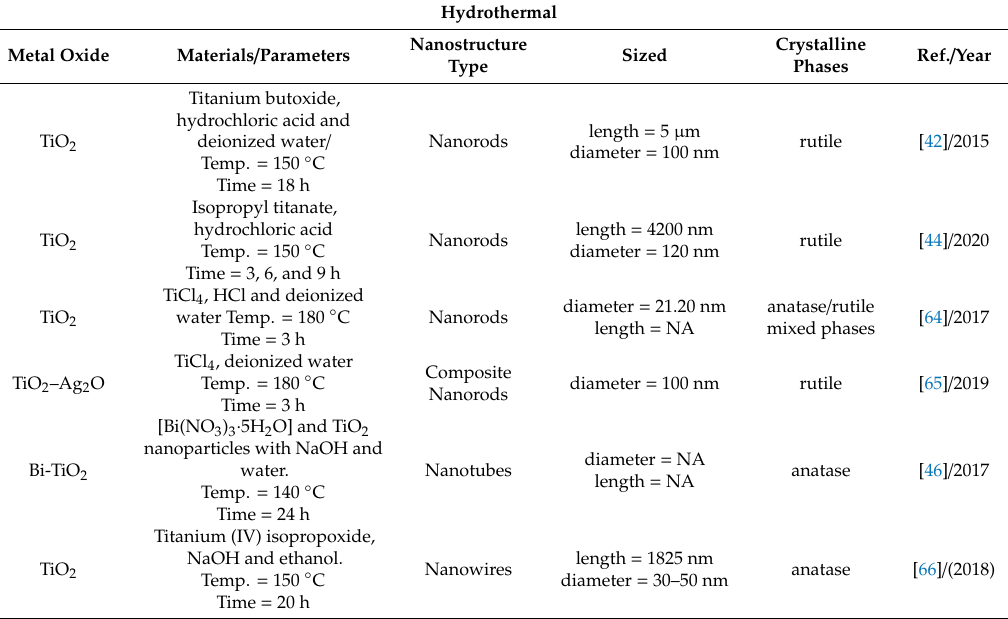
Table 2. Summarization of di ff erent materials, parameters, crystal phase involved in the growth process of TiO 2 nanostructures and its composites for di ff erent fabrication